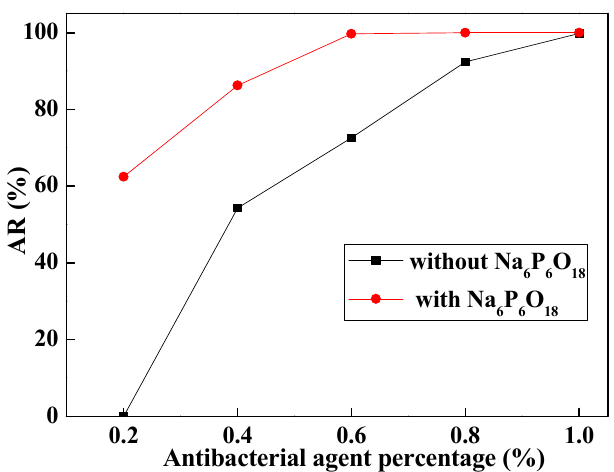
Figure 3. Antibacterial ratio of Ag-HZDP-melamine resin solution-coated cedar parquet floor, with and without Na 6 P 6 O 18 .